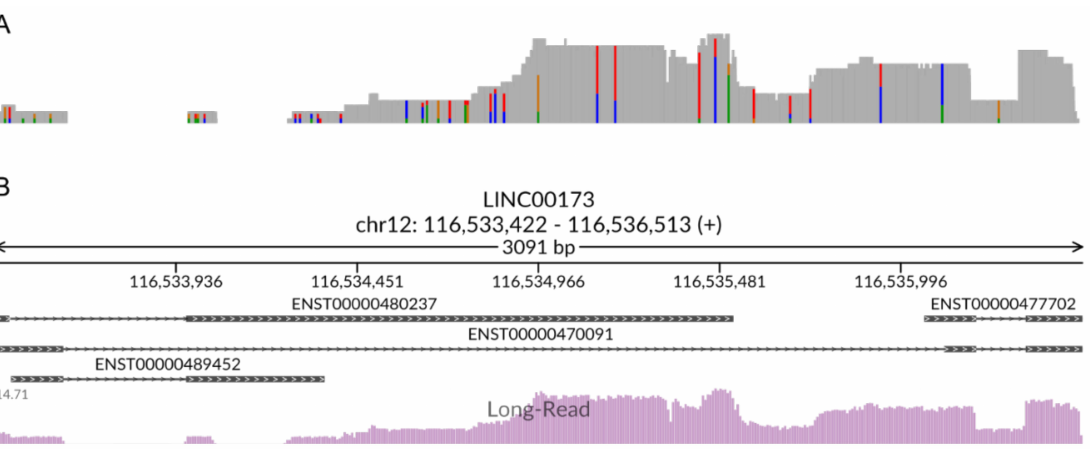
Figure 5. svist4get rapidly generates a coverage map for a locus of interest. ( A ) The LINC00173 coverage map visualized with IGV compared to ( B ) the locus-specific coverage map produced by